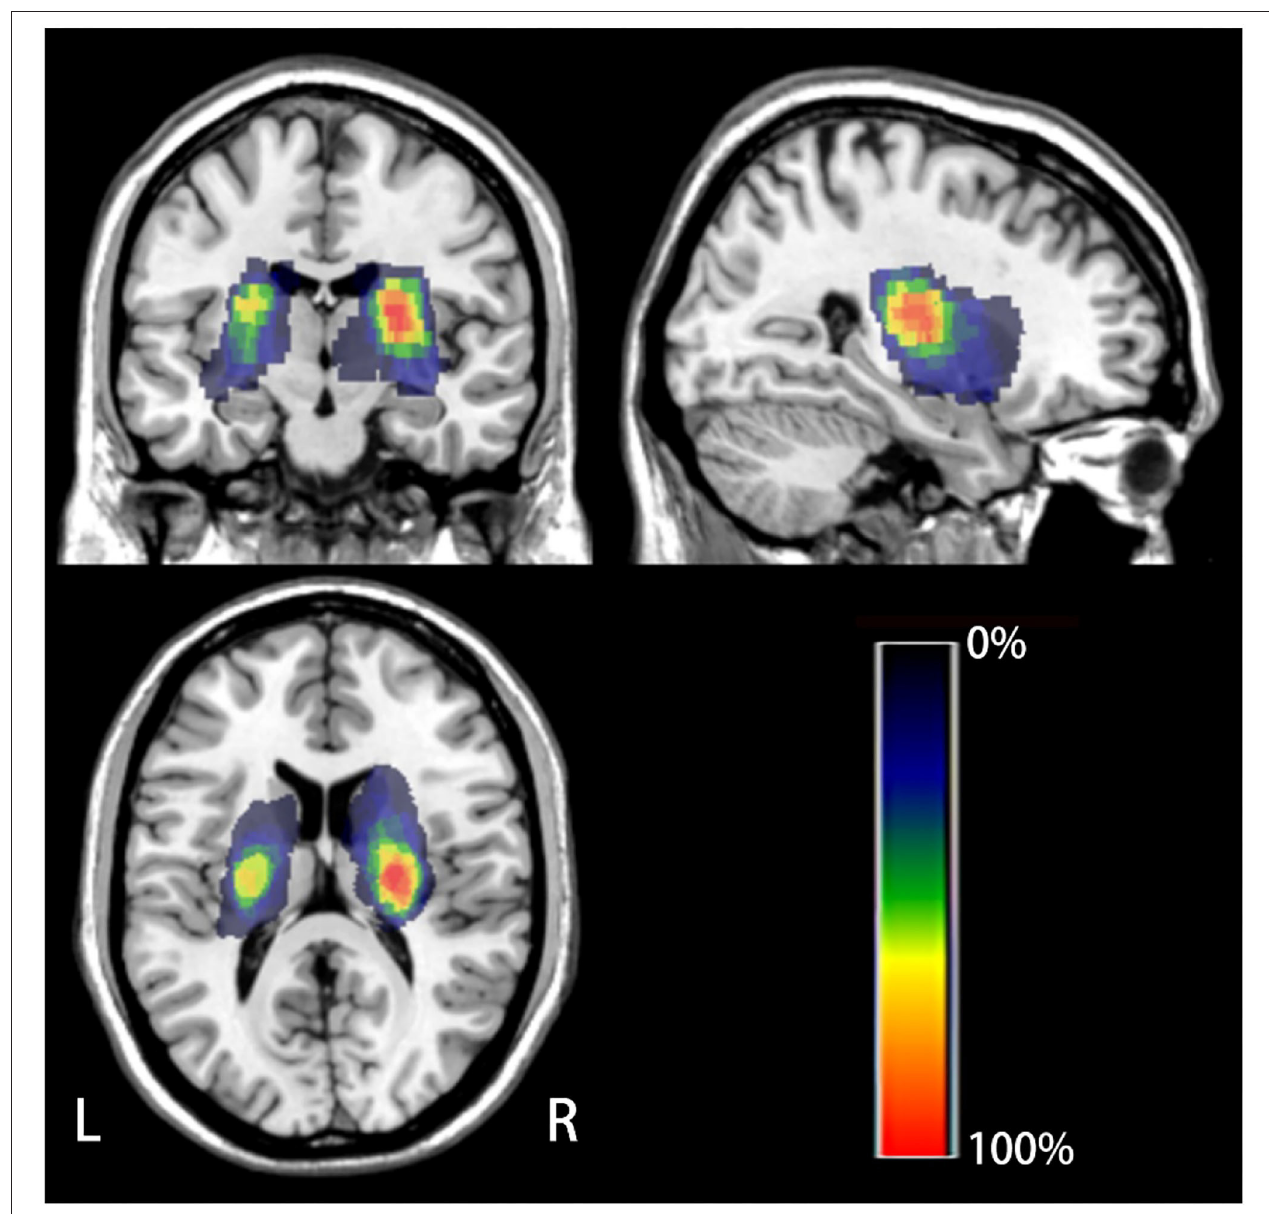
FIGURE 2 | The lesion probability map of all the patients with stroke. The color indicates the frequency of superposition.